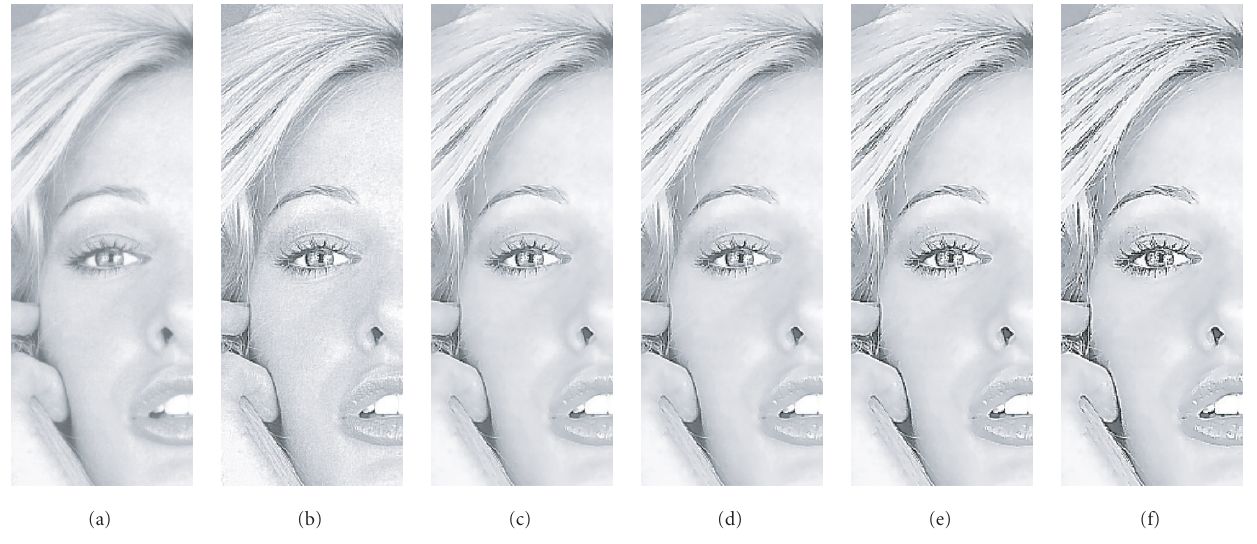
Figure 6: (a) Detail of original noise-free image, and results given by di ff erent parameter settings: (b) k sh = 5 and k sm = 0, (c) k sh = 5 and